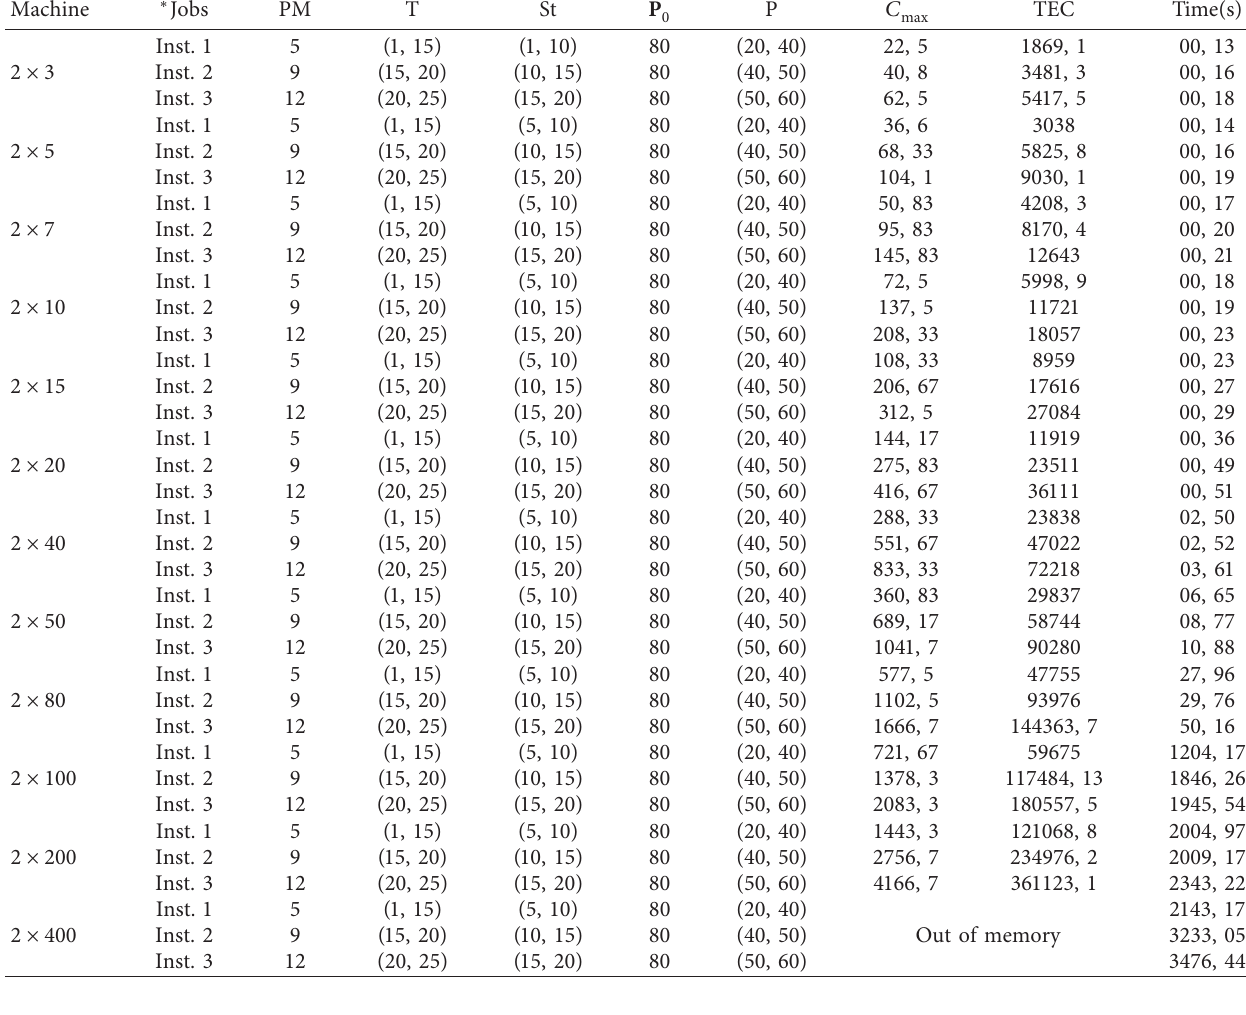
Table 2: Recapitulation of the calculation results.